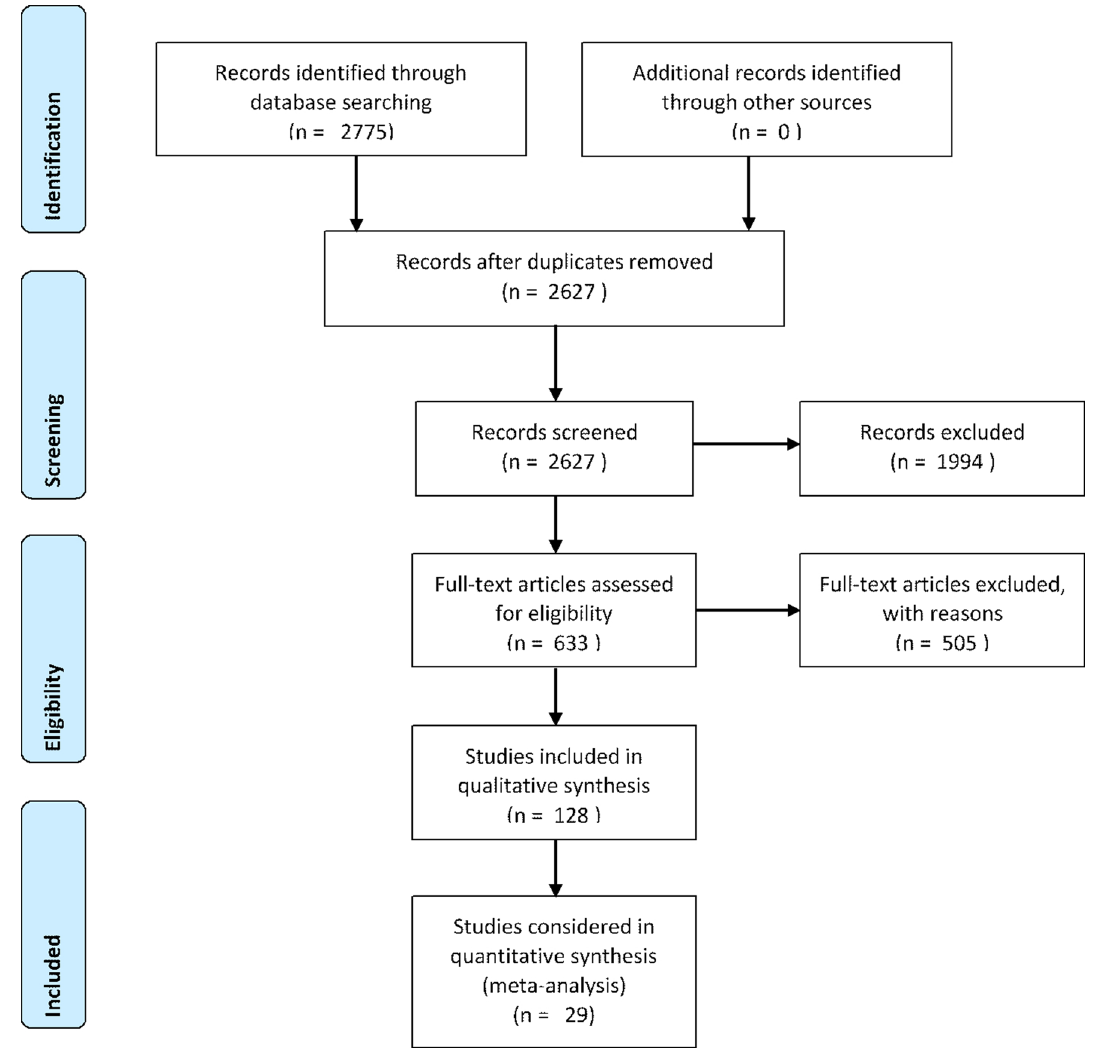
Figure 1. PRISMA flow chart detailing the literature search